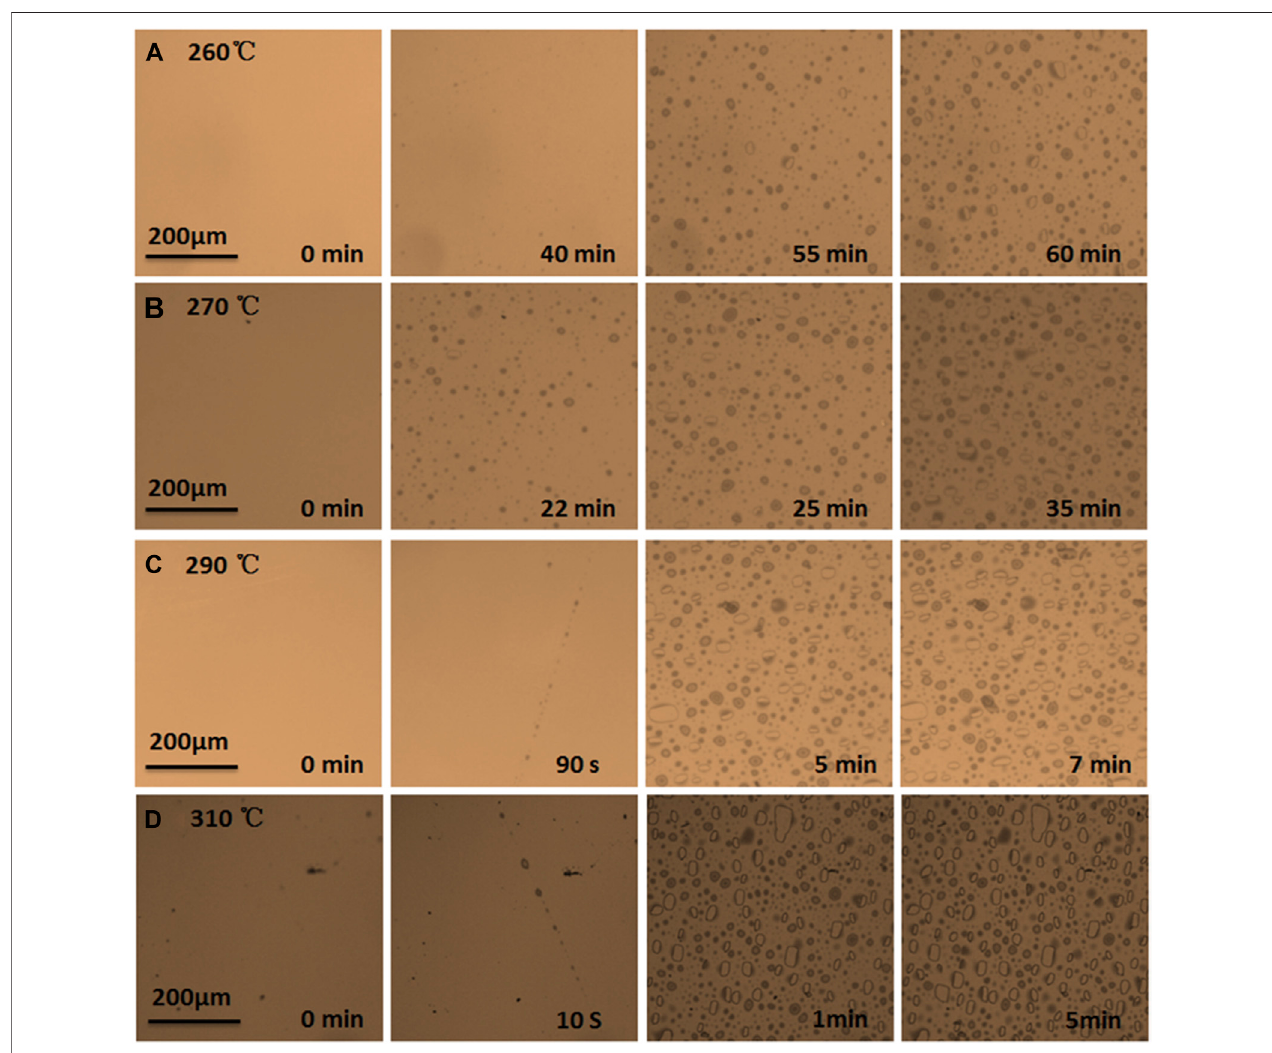
FIGURE 2 | Surface blistering of 128 ° Y – X LN implanted with a dose of 2.5 × 10 16 ions cm − 2 annealed at (A) 260 ° C, (B) 270 ° C, (C) 290 ° C, and (D) 310 ° C.